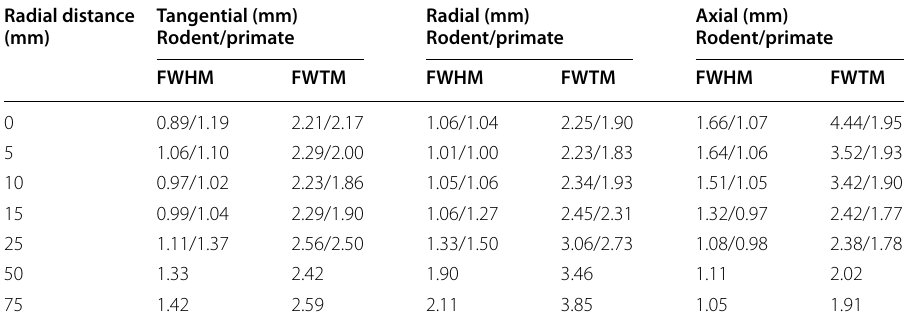
Slice thickness (mm): 0.84